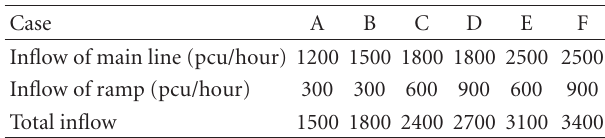
Table 2: Tra ffi c